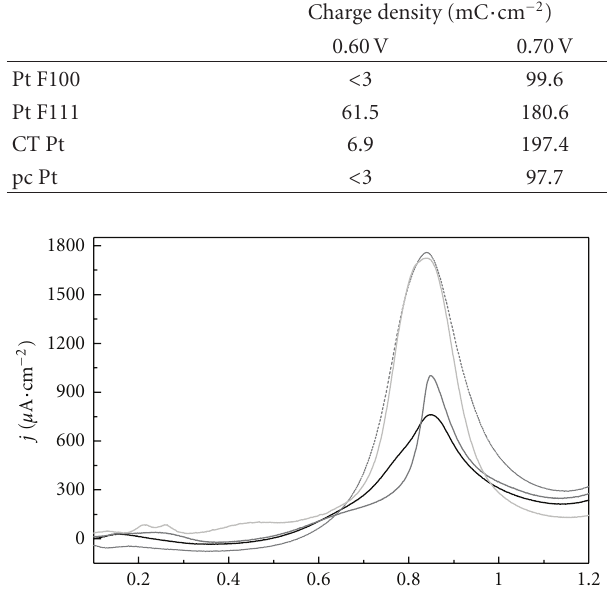
Figure 3: First positive-going potential scan for methanol oxidation run at 0.10Vs − 1 between 0.10 and 1.20 V in oxygen-free 0.1 M methanol + 1 M sulphuric media on Pt F(111) (dotted gray lines); CT Pt (gray lines); Pt F(100) (dark gray lines) and annealed Pt (black lines).